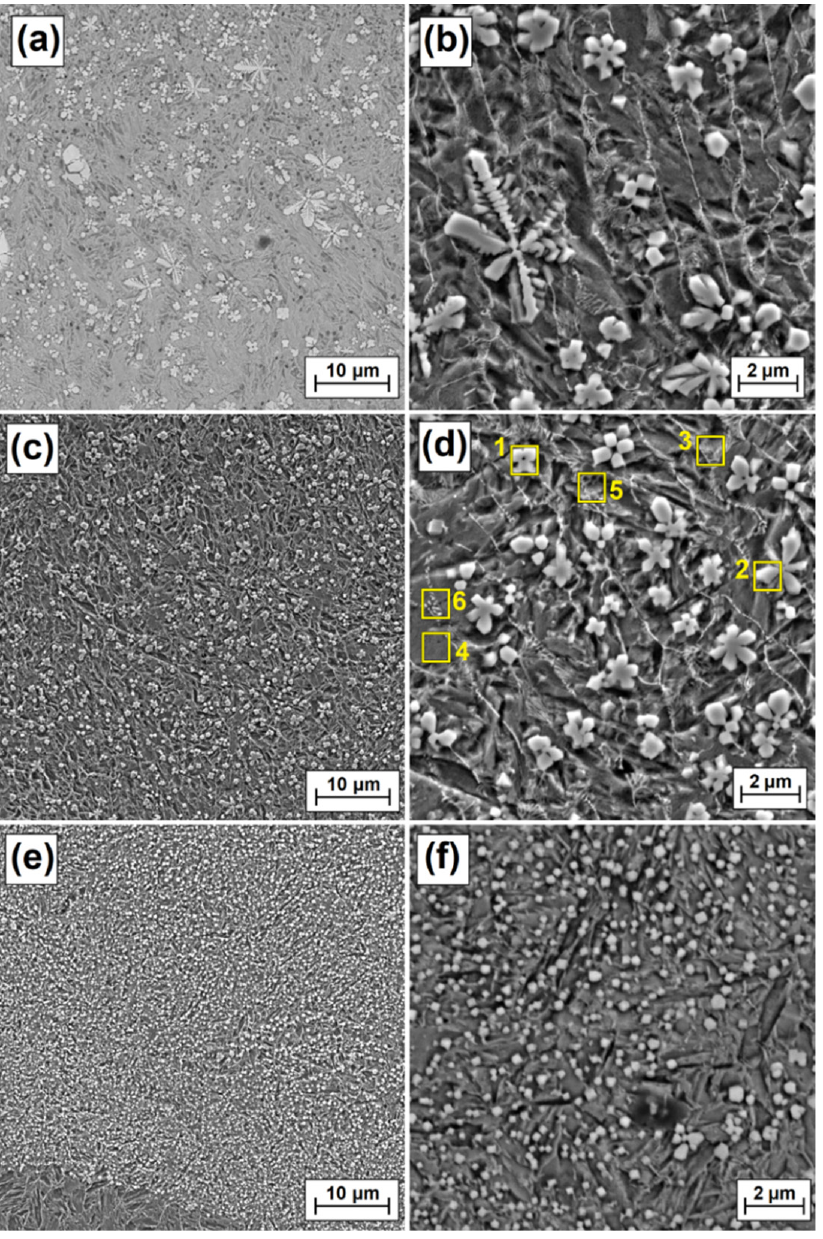
Figure 8. Melted zone microstructure of Fe/ZrC coatings produced using laser beam power of 900 W; subsurface area ( a ), magnification of subsurface area ( b ), middle area ( c ), magnification of middle area ( d ), sub-substrate area ( e ), magnification sub-substrate area ( f ) .